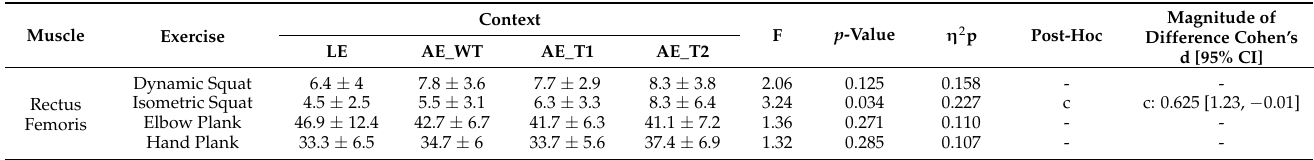
Table 3. Descriptive analysis (mean ± standard deviation) of EMG magnitude (%) and inferential analysis of the activation of the rectus femoris muscle as a function of the exercises and taking into account the context factor.